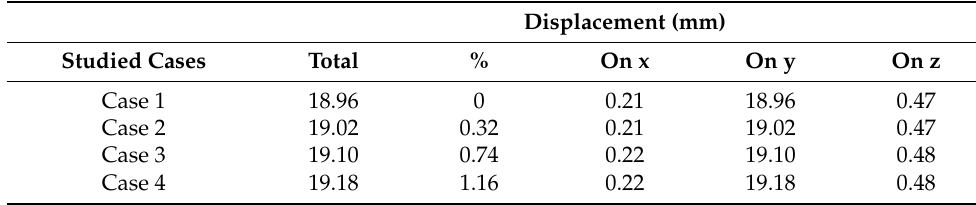
Table 2. The displacement values for each studied